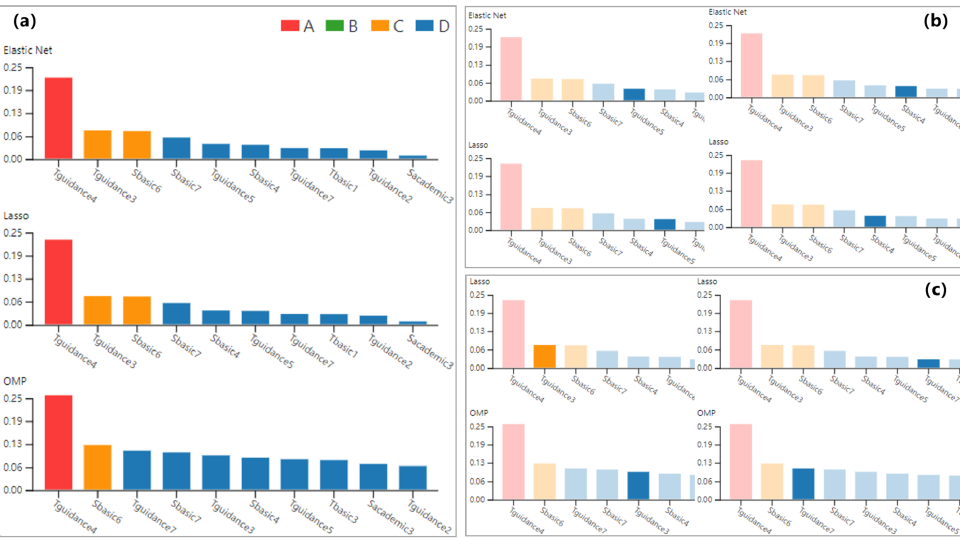
Figure 3. A presentation of the ranking results in three factor selection methods, i.e., Lasso, EN, and OMP ( a ). When the factor that users are interested in is selceted, the other factors’ colour will be lightened to highlight the selected one. ( b ) shows the comparison of changes in factors ranking (Tguidance5 and Sbasic4) between Lasso and EN, which presents a small change in ranking. While, ( c ) shows the large changes in factors ranking (Tguidance3 and Tguidance7) between Lasso and OMP. In order to combine the results of the two feature selection methods, the attribute set is added to the same degree, that is, in the Lasso and OMP, the attributes of A, B, C, and D grades are assigned 8, 6, 4, and 2 scores (0 points are not selected for filtering), and then the average value is obtained. For example, Tguidance3 has a score of 4 in Lasso, a score of 2 in OMP, and the final score of Tguidance3 is 3 on the average of 2 and 4. The weighted division [1, 2.75]-D, [2.75, 5.5]-C, [5.5, 6.25]-B and [6.25,